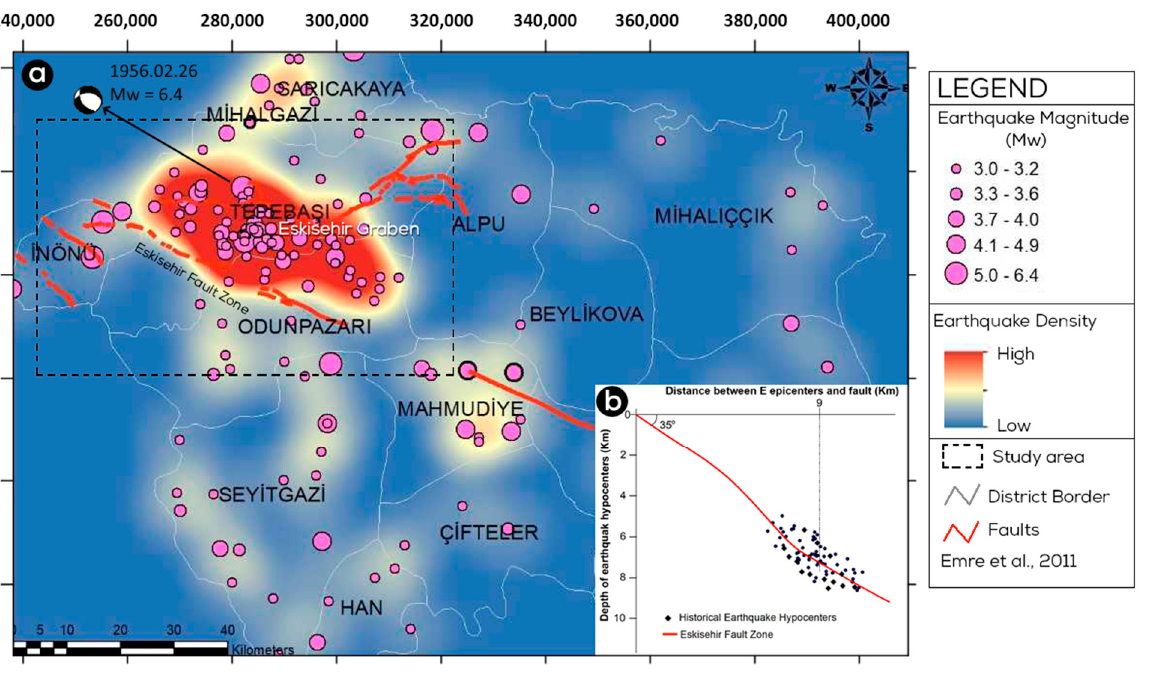
Figure 2. ( a ) An earthquake density map showing the distribution of earthquakes from 1900–2019. ( b ) Schematic graphics of earthquake focal points along the EFZ in the Eskisehir Graben [36] (datum: WGS84 UTM Zone 36 N).